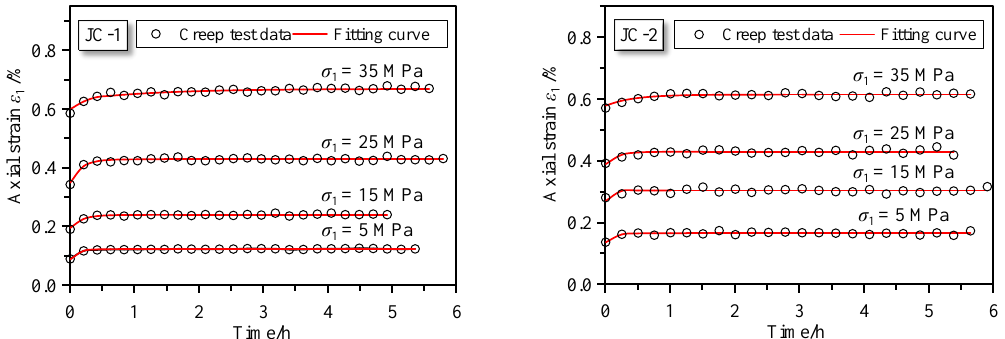
Figure 8. Comparison between fitting curves and creep test data of coal specimens.